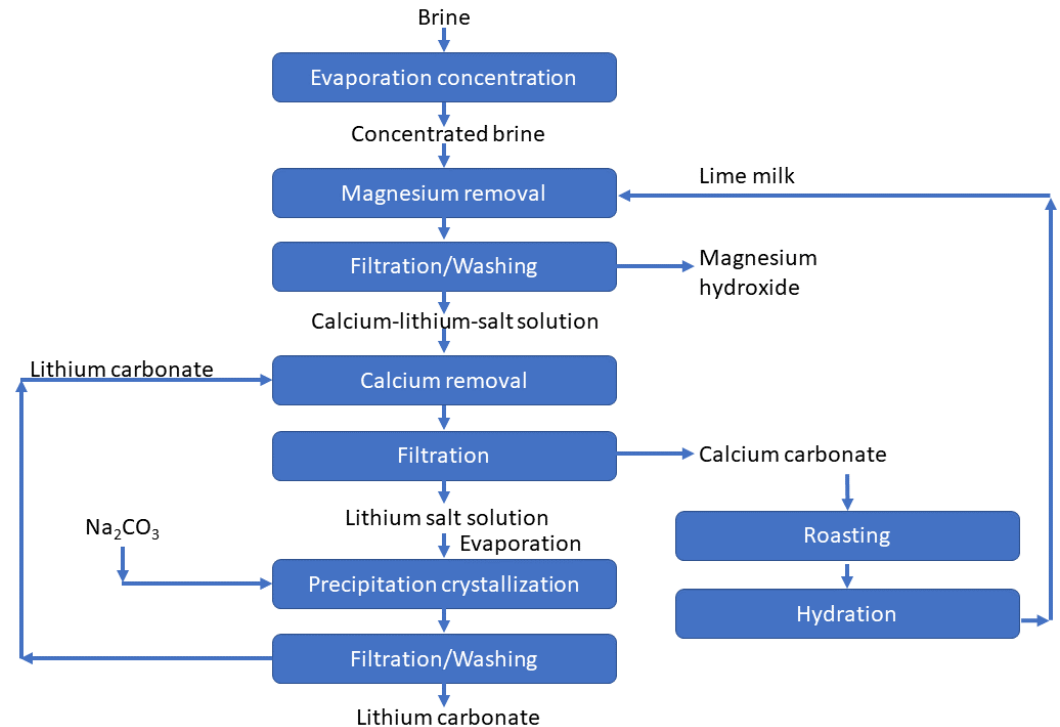
Figure 9. Flow-chart for lithium extraction as lithium carbonate from salar brine, adopted from [56]. Reprinted (modified) from Hydrometallurgy, v. 150, Meshram et al., Extraction of lithium from primary and secondary sources by pre-treatment, leaching and separation: A comprehensive review, 192 – 208, Copyright 2014, with permission from Elsevier.